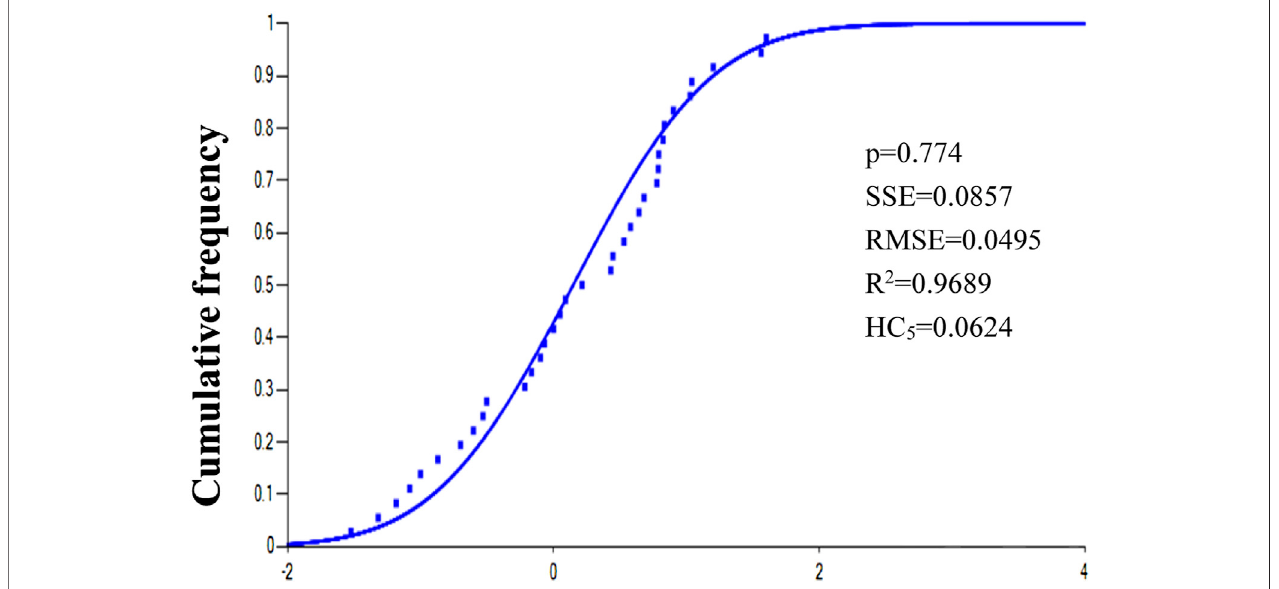
FIGURE 3 | SSD curve of Hg for aquatic species (HC 5 (cid:1) 0.062 mg/kg, R 2 (cid:1)